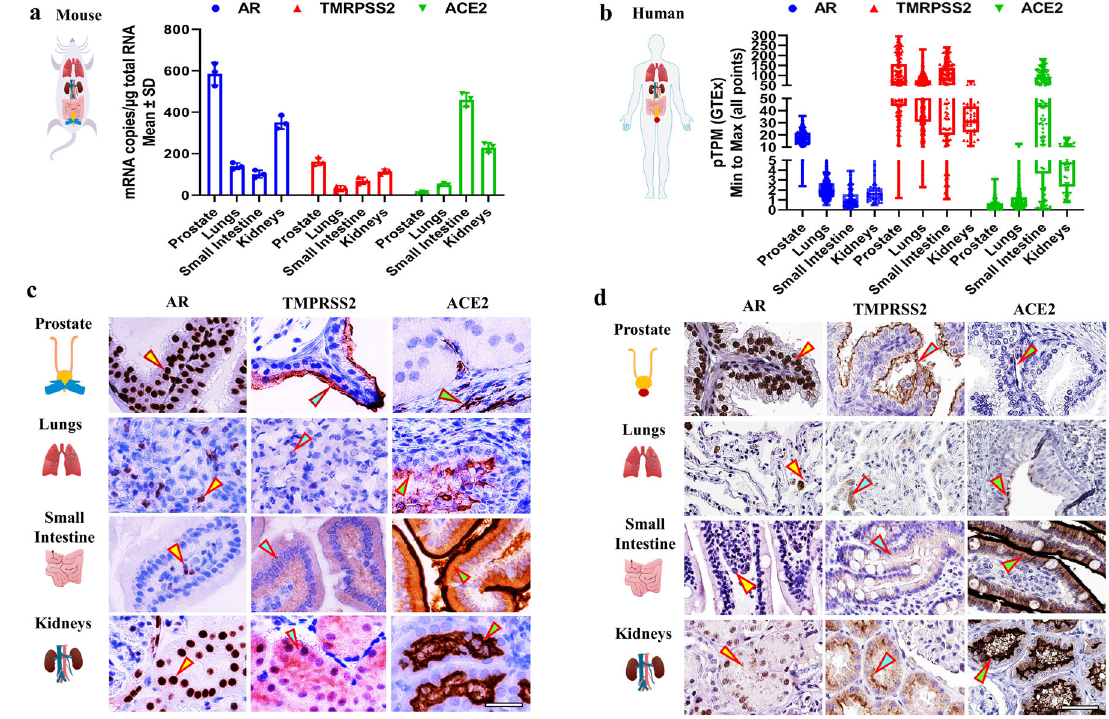
Fig. 1 Tissue expression and localization of AR, TMPRSS2, and ACE2 in mice versus in humans. a The relative mRNA expression levels of Ar , Tmprss2 , and Ace2 in prostate ( n = 3), lungs ( n = 3), small intestine ( n = 3), and kidneys ( n = 3) in 8-week-old male C57BL/6 mice were quanti fi ed by qRT-PCR. qPCR values (mean ± SD) are expressed as mRNA copies/µg total RNA. b The mRNA expression levels of AR , TMPRSS2 , and ACE2 in the prostate ( n = 152), lungs ( n = 427), small intestine ( n = 137), and kidneys ( n = 45) in adult humans were extracted from the “ The Human Protein Atlas/The Genotype-Tissue Expression (GTEx) Dataset ” . GTEx dataset reports mRNA expression of each gene in human tissue as average pTPM. The data were presented by box plots showing all values. c The localization of AR, TMPRSS2, and ACE2 in the prostate, lungs, small intestine, and kidneys in 8-week-old male C57BL/6 mice were displayed by immunohistochemistry (IHC). d The IHC images of AR, TMPRSS2, and ACE2 in the prostate, lungs, small intestine, and kidneys in adult humans were extracted from the “ The Human Protein Atlas/ Protein Expression Summary ” subcategory. In the database of The Human Protein Atlas, IHC staining was performed on normal human tissue. The scale bar of representative images is ×40 by 100 μ